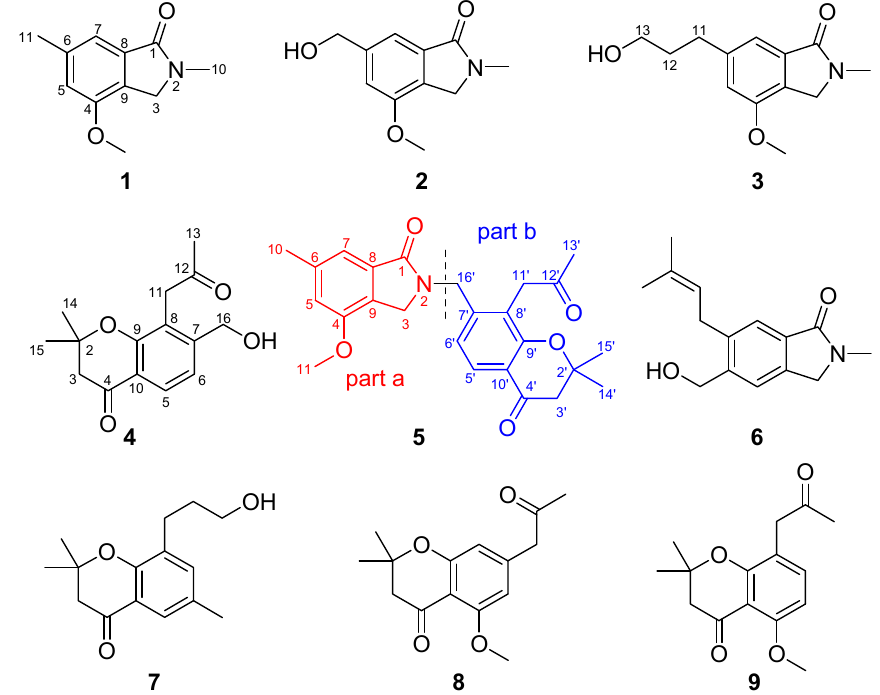
Figure 1. The structure of compounds 1 – 9 from C. alata . Table 1. 1 H and 13 C NMR data for compounds 1 – 3 (in CDCl3, 500 and 125 MHz). No.